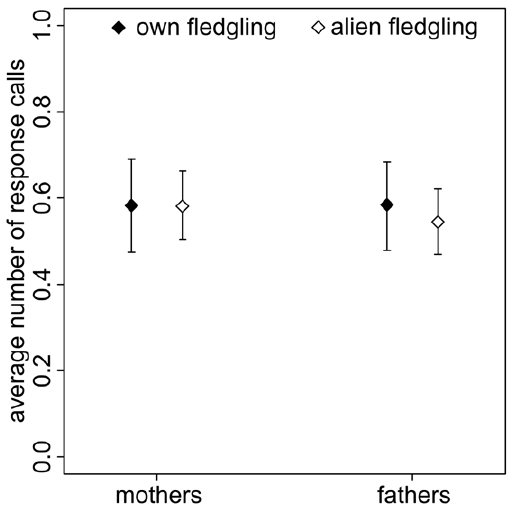
Figure 4. Average number of response calls ( ± standard errors) for mothers and fathers to own and alien fledgling